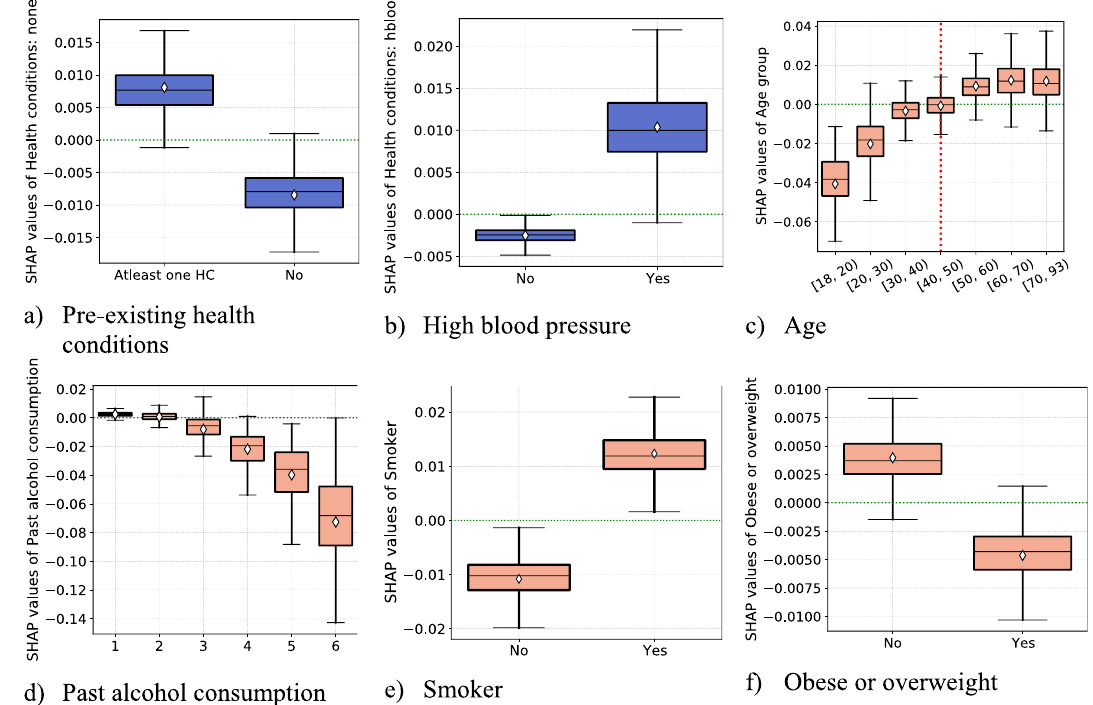
Figure 5. Partial effects of pre-existing health conditions and behavioral risk factors. Notes : Each panel ( a )–( f ) display SHAP dependence boxplots of pre-existing health conditions and behavioral risk factors. The diamond symbol in the boxes denotes the average of SHAP value distribution per each category. In panel ( d ), the labels in the x-axis correspond to the number alcohol consumption in number of glasses in an average week: (1) “ < 5”, (2) “[5, 10)”, (3) “[10, 15)”, (4) “[15, 20)”, (5) “[20,25)”, (6) “ ≥